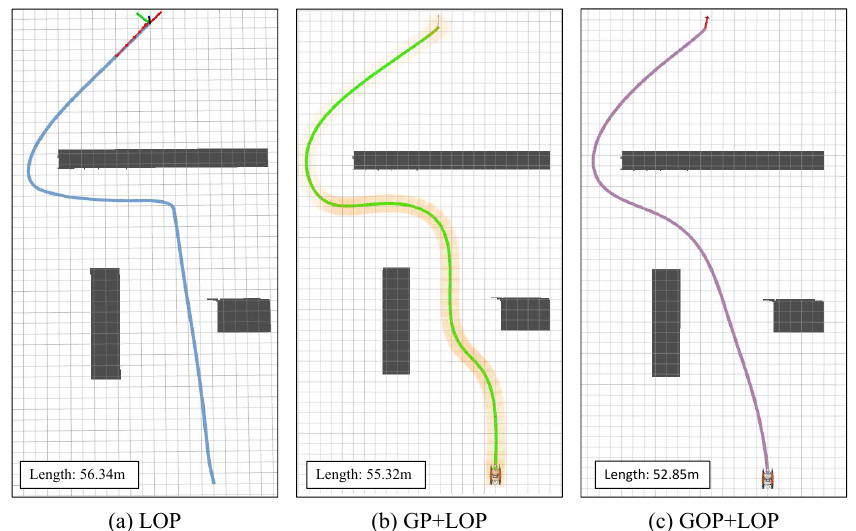
Figure 7. Trajectory generation comparison with different methods. LOP: trajectory generation with local optimization planning (global map provided by the UAV is unknown); GP+LOP: global planning without trajectory optimization; and GOP+LOP: the proposed method.